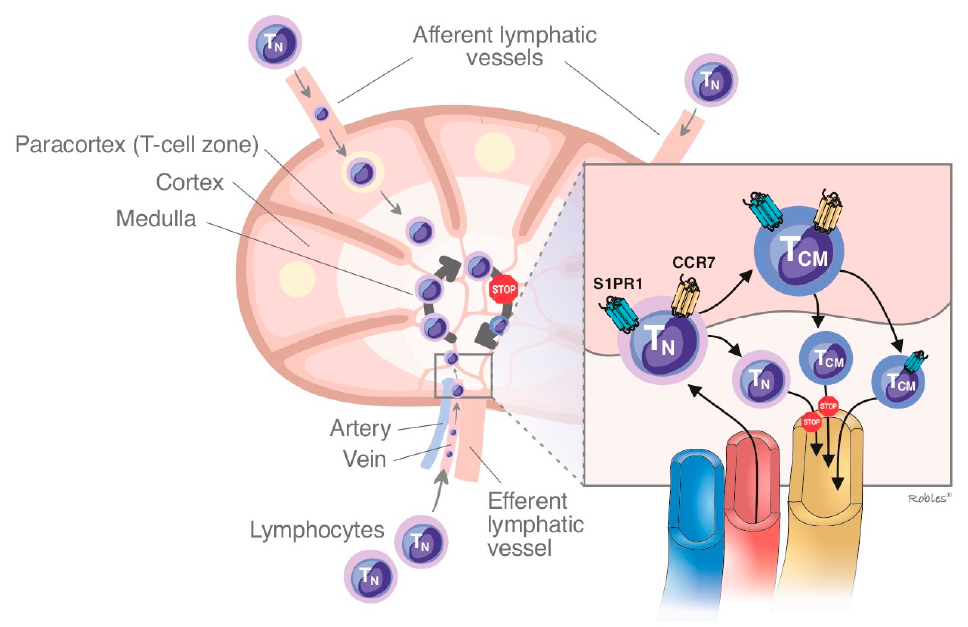
Figure 3. The effect of S1PR1 internalization in the lymph nodes and how regulates the gradient of lymphocytes between SLO/blood. This scheme shows the sequestration of naive T cells and CCR7 expressing central memory T cells due to the inability to response to the altered lymphocyte gradient between SLO/blood. S1PR = Sphingosine1-phosphate receptor; TN = naÏve T cells; TCM = central memory T cells; SLO = secondary lymphatic organs.